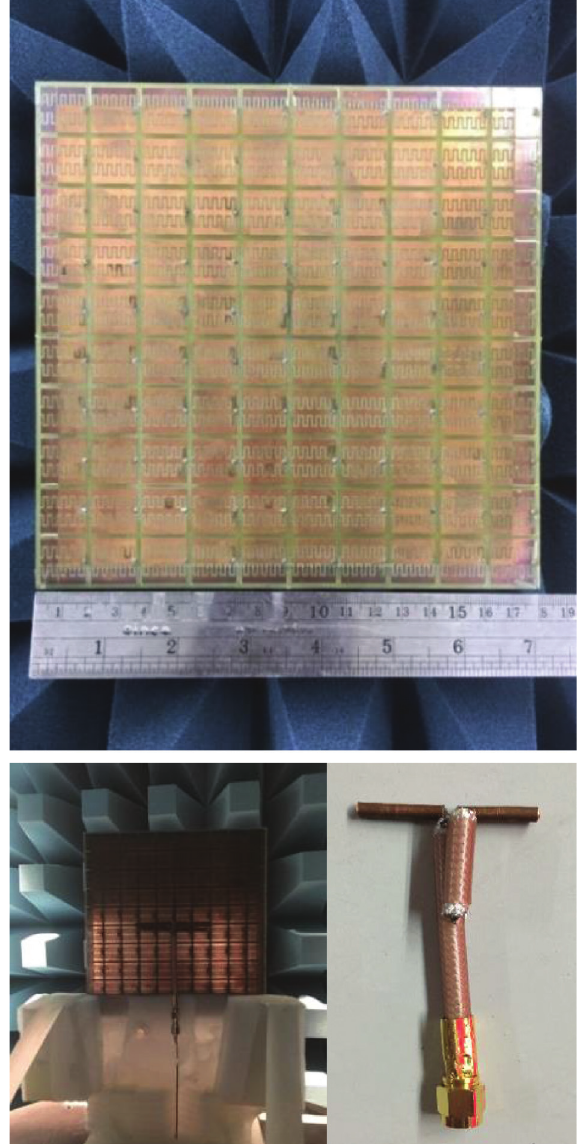
Figure 16: The created geometry of ICPW-EBG reflector and dipole antenna on the antenna gain